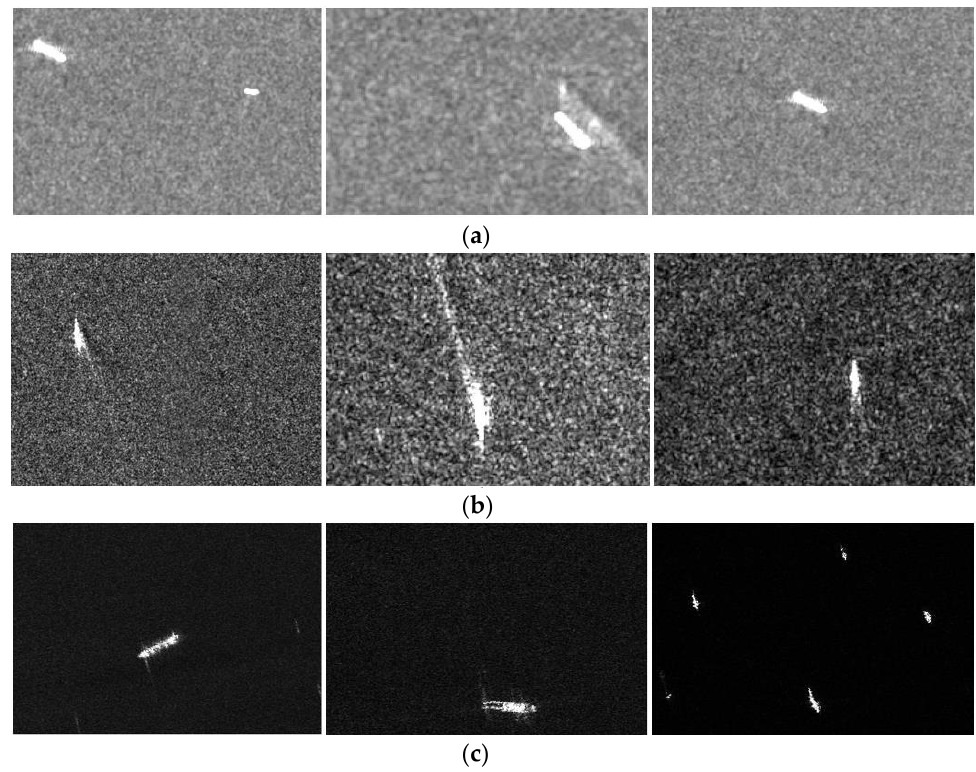
Figure 3. SAR images under different noises: ( a ) SAR image with a lot of noise; ( b ) SAR image with less noise; ( c ) SAR image with a small amount of noise.